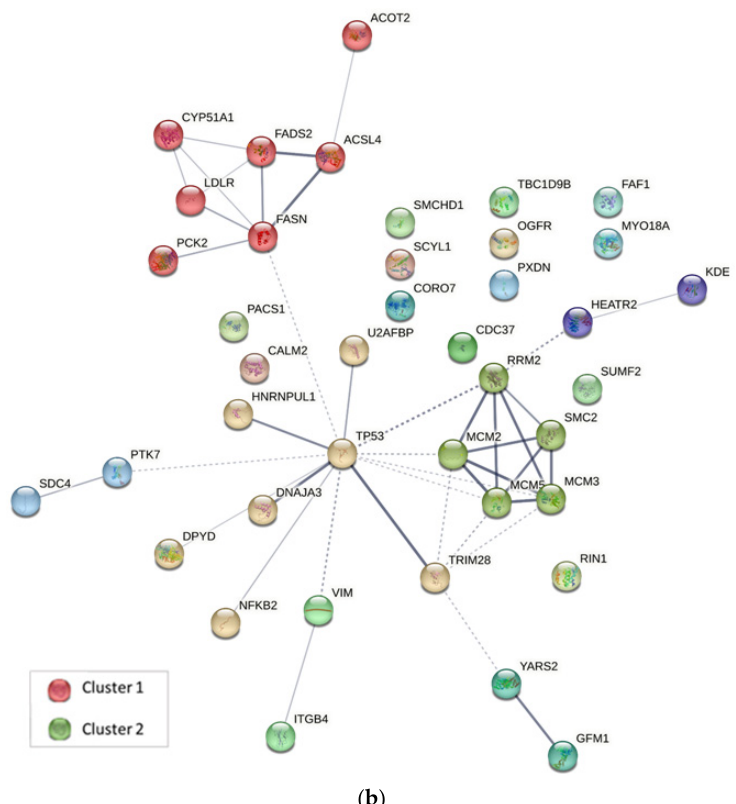
Figure 5. Interaction network for down-regulated proteins of MDA-MB-231 cells in response to treatment with ( a ) CuHL1 and ( b ) CuHL2 generated using the STRING v11.5 database. The thickness of the line indicates the degree of confidence of the interaction. A variety of interaction sources were included into the search strategy, such as text mining, experiment record, database record, coexpression, neighborhood, gene fusion, and co-occurrence.